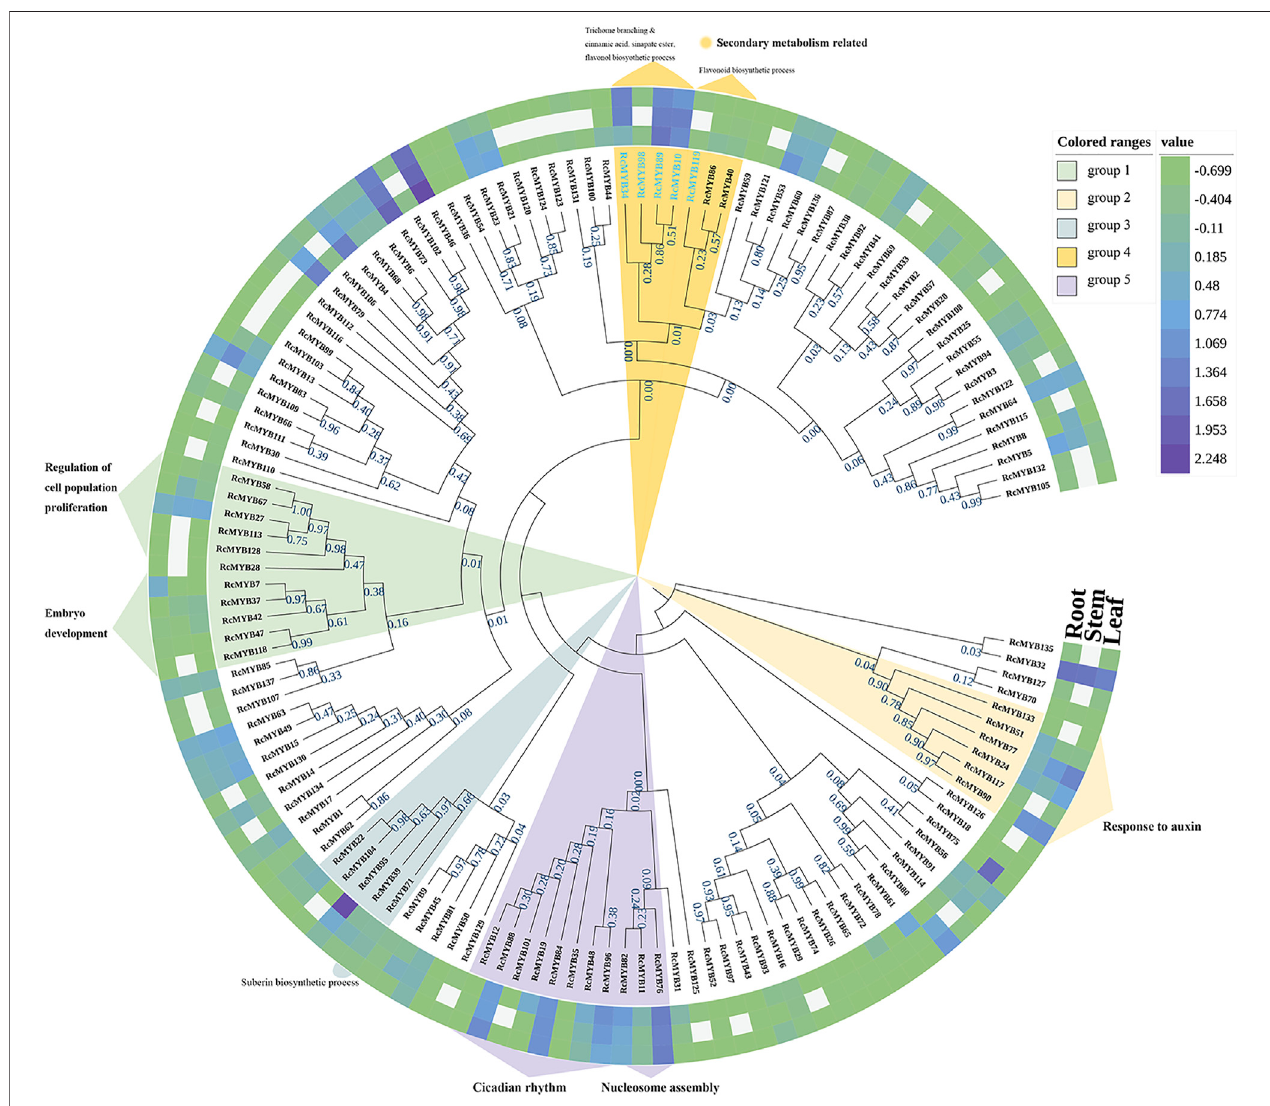
FIGURE1| Phylogenetictreeof RcMYB geneswiththeirrelativeexpression levelsinthreetissues modi fi edbyiTOLv6.0. Functional annotationswerepredicted by BLAST in the TAIR database. Blank cells indicated data gaps and the labels of the selected RcMYBs were dyed blue. Value is equal to log 10 (FPKM+0.2) .